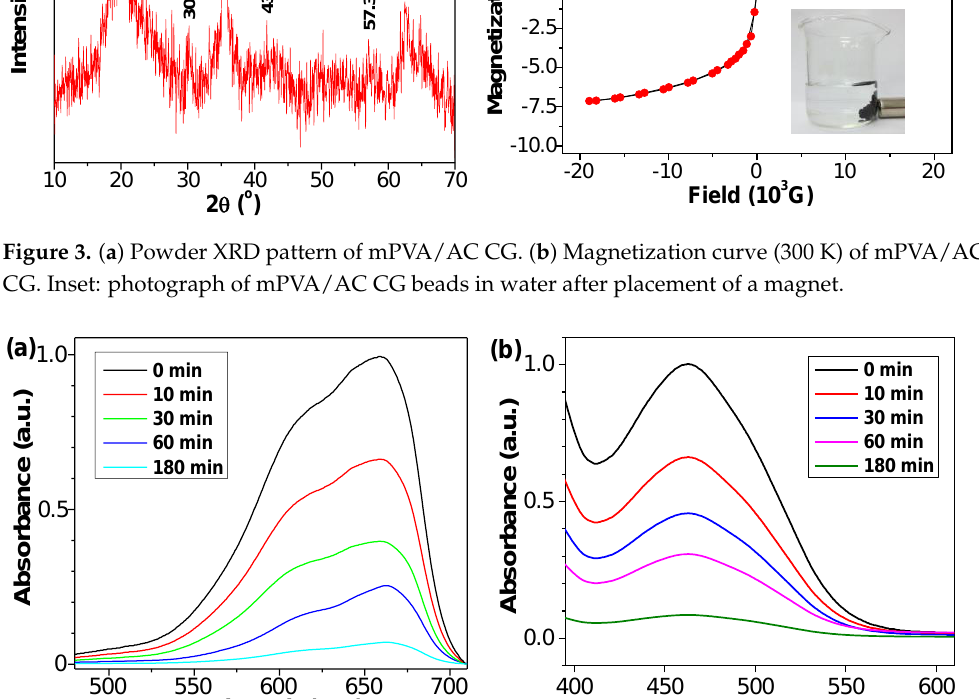
Figure 3. ( a ) Powder XRD pattern of mPVA/AC CG. ( b ) Magnetization curve (300 K) of mPVA/AC CG. Inset: photograph of mPVA/AC CG beads in water after placement of a magnet.